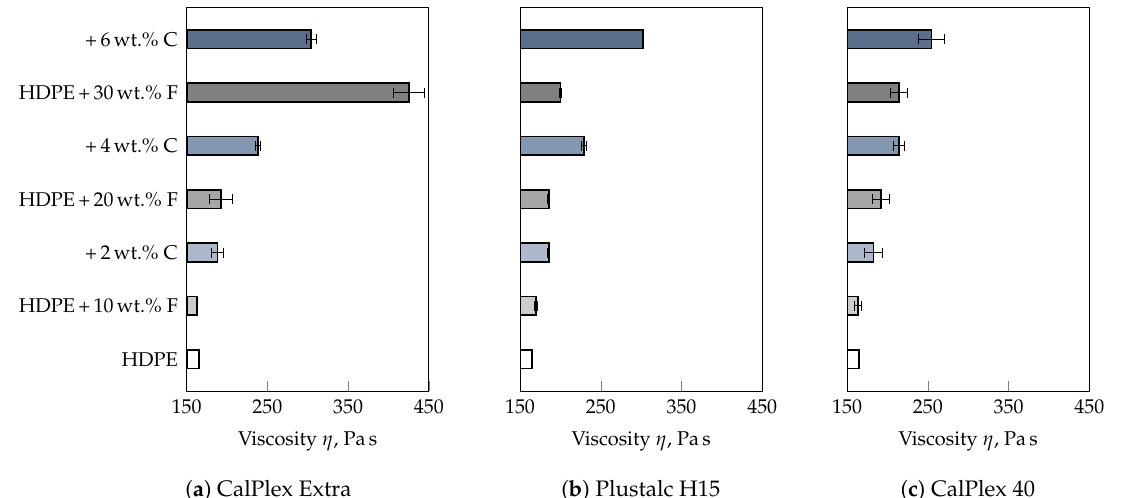
Figure 14. Viscosity values in the linear viscoelastic range (strain of 10%), obtained at a test temperature of 215 ◦ C and a shear rate of 500 s − 1 . Fillers with ( a ) small diameters (CalPlex Extra) cause a more pronounced increase in viscosity compared to fillers with ( b ) medium (Plustalc H15) and ( c ) high (CalPlex 40) D 50-values. Compatibilizer is marked as C and the filler as F. Table 9. Correlations of viscosity values η and impression quality ∆ ¯ R a of the insert with low roughness for selected formulations. Viscosities were determined in the linear viscoelastic range (strain of 10%) at a test temperature of 215 ◦ C and a shear rate of 500 s − 1 . Compatibilizer is marked as C and the filler as